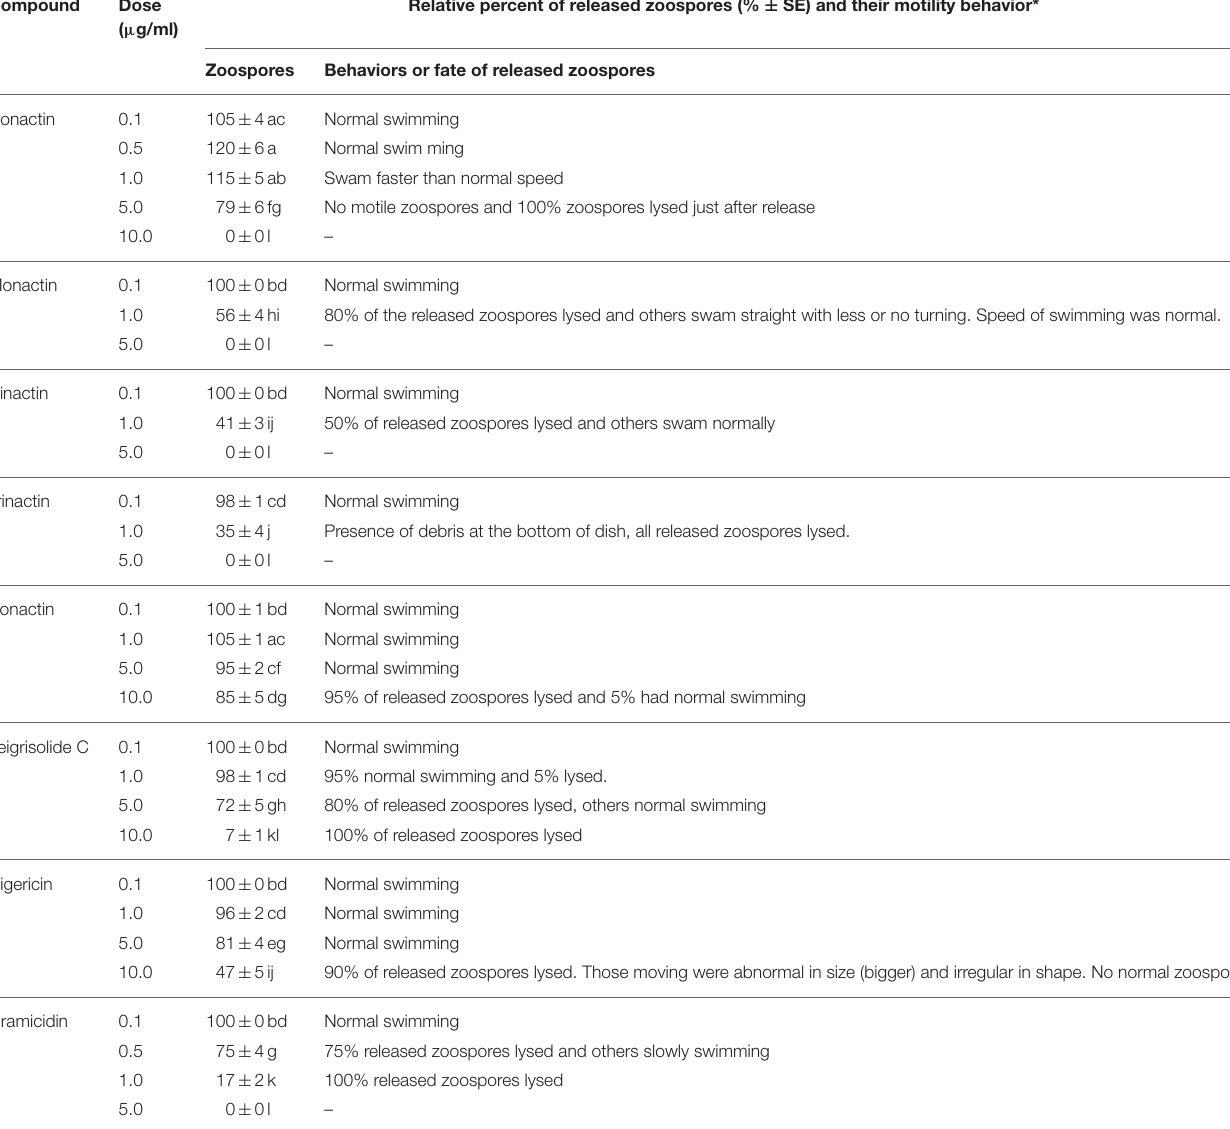
TABLE 5 | Effects of macrotetrolide antibiotics, and bonactin, feigrisolide C, nigericin and gramicidin on the release of zoospores from sporangia (zoosporogenesis) of the grapevine downy mildew pathogen Plasmopara viticola . Compound Dose Relative percent of released zoospores (% ± SE) and their motility behavior* ( µ g/ml) Zoospores Behaviors or fate of released